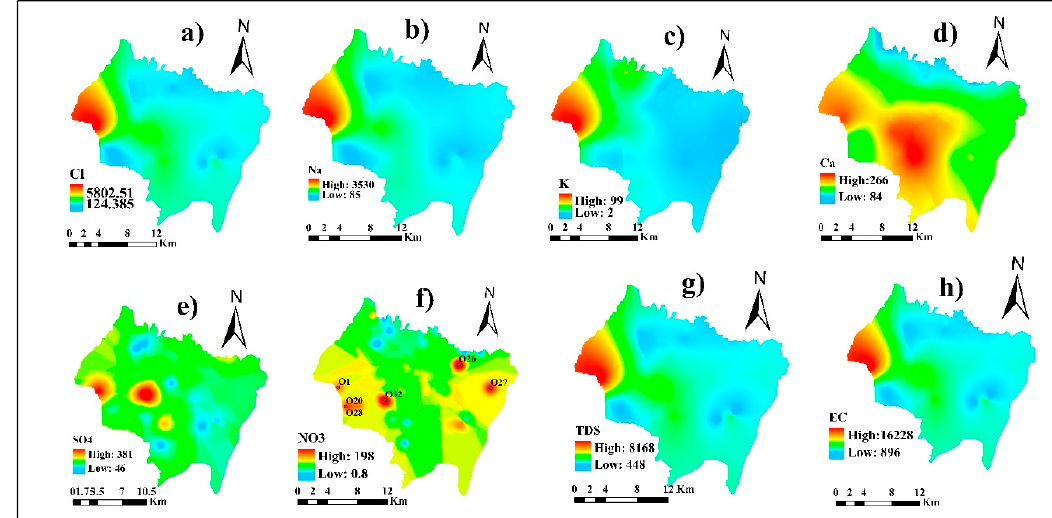
Figure 9. Spatial distribution of groundwater physicochemical parameters (( a ) Cl, ( b ) Na, ( c ) K, ( d ) Ca, ( e ) SO 4 , ( f ) NO 3 , ( g ) TDS and ( h ) EC) in the Essaouira Basin based on the 2019 campaign.